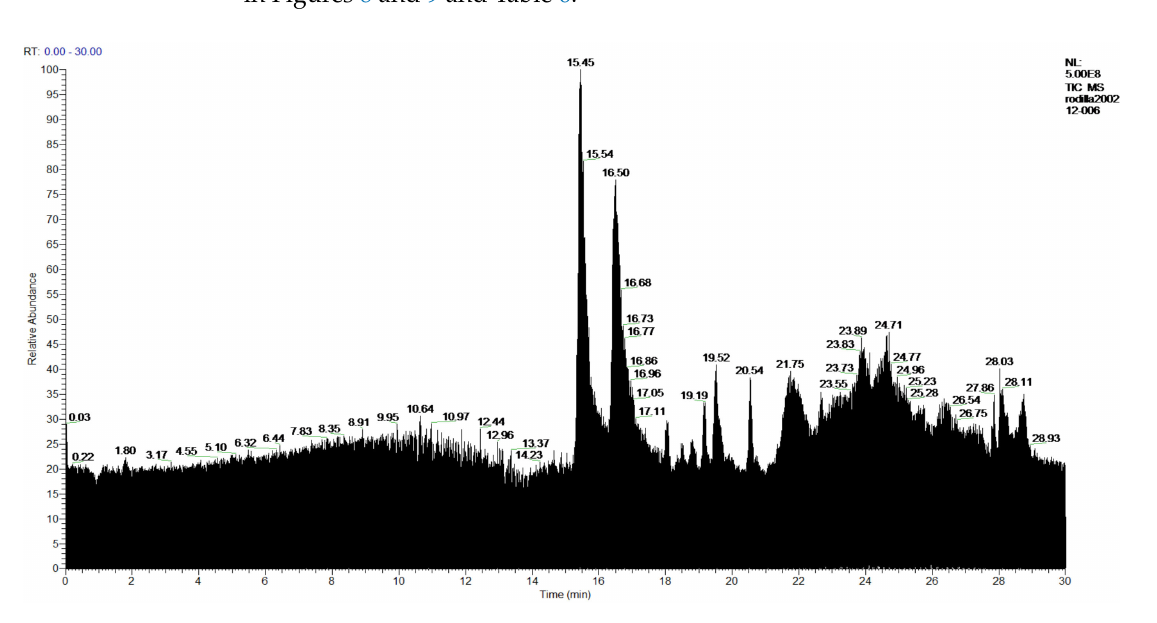
Figure 8. Chromatogram of Hexane extract part insoluble in MeOH, 1-Cires .